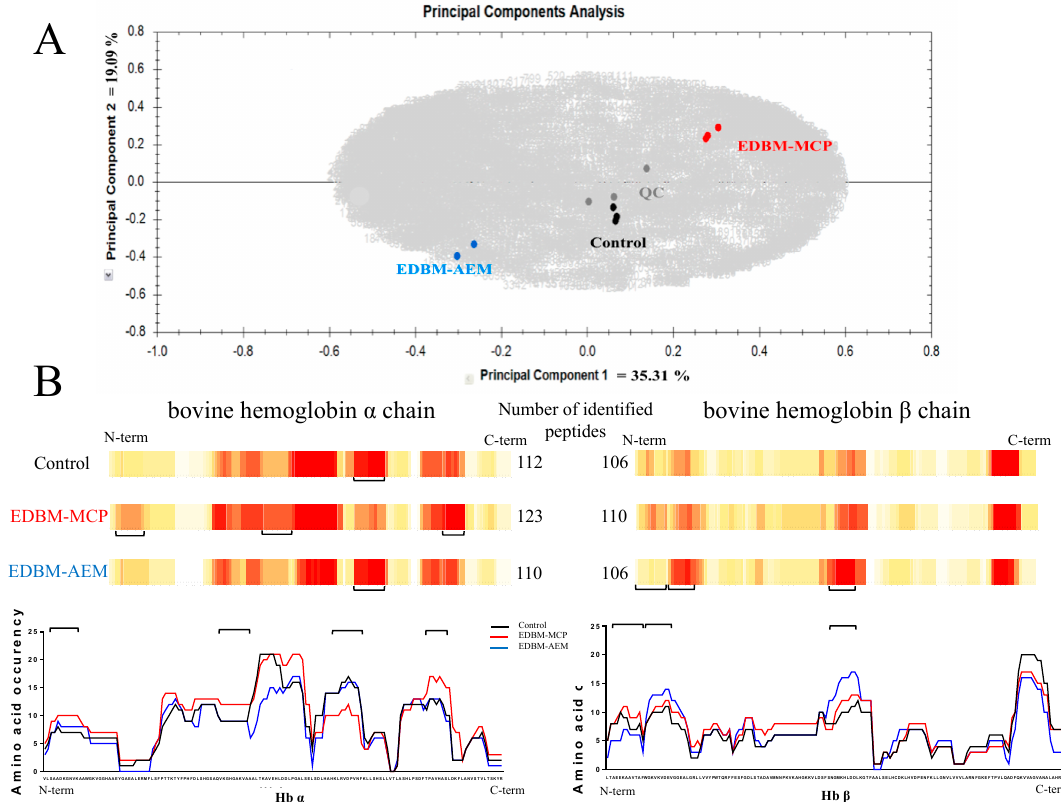
Figure 9. ( A ) Principal component analysis based on comparison of mass spectrometry detected ions in bovine hemoglobin hydrolysates. Quality control (QC) samples correspond to equivolume mixtures of the 9 hydrolysates (three control, three EDBP-AEM and three EDBM-MCP) injected at the beginning, the middle and the end of the HPLC-MS/MS analysis session. ( B ) Heat maps showing amino acid occurrence in the identified peptides in the primary sequences of the bovine hemoglobin α and β chains after its hydrolysis in the three conditions. Underlined regions highlight peptide pattern differences. Heat maps were generated after combination of three LC-MS/MS analysis for each replicate.